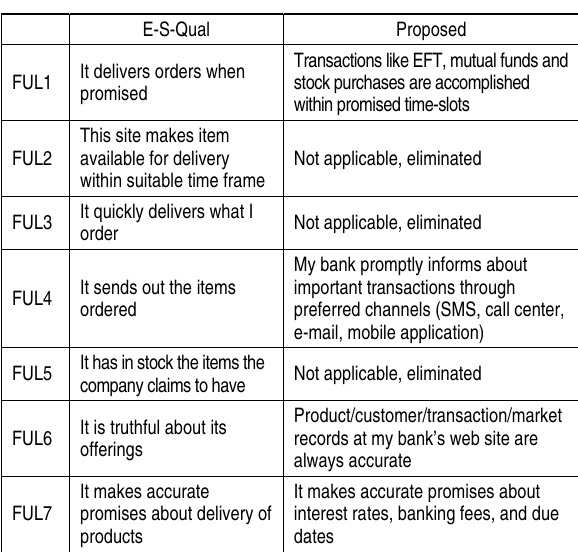
Table 5. Fulfillment questions (FUL)